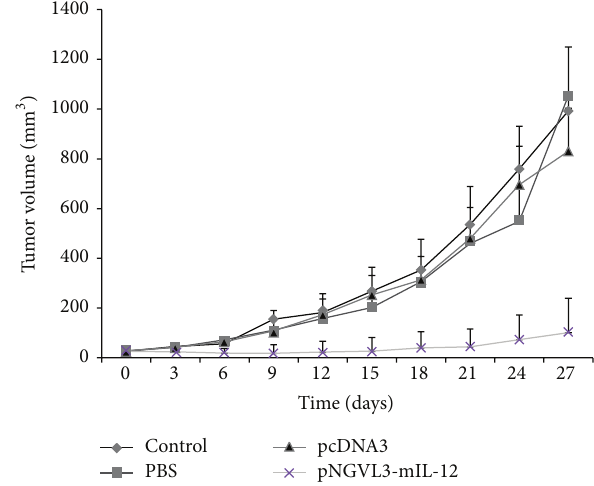
Figure 1: Effect of administration of naked IL-12 DNA on tumor growth. The potential therapeutic effect of naked DNA/IL-12 was evaluated in an experimental tumor model. Each group of mice ( 𝑛 = 5 ) was challenged subcutaneously with 5 × 10 5 BMK-16/myc cells. When the tumor reached 20–30 mm 3 in size, in the tumor sites were injected three-times (every six days) with 50 𝜇 g pNGVL3- mIL-12 (asterisks), pcDNA3 plasmid (triangle), PBS (square), or no treatment as control (diamond). Tumor size was measured every 3 days over 27 days. Values and bar represent the average and standard deviations of the tumor size. ANOVA, 𝑃 < 0.05